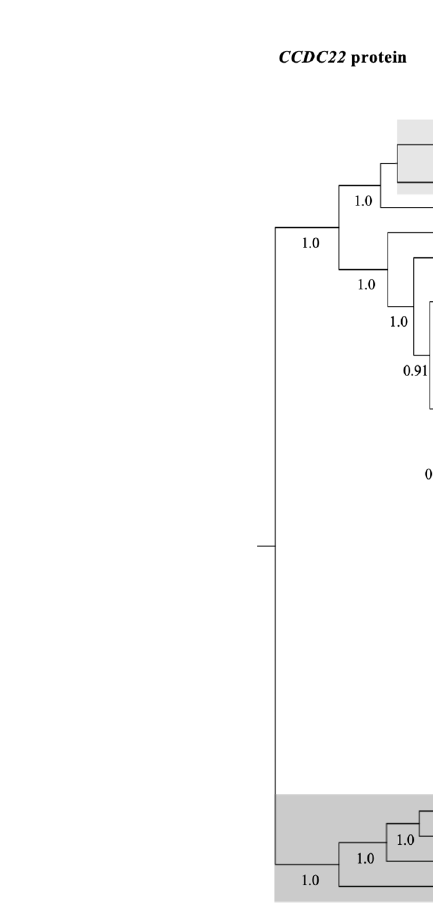
FIGURE 3 Majority rule consensus tree based on Bayesian phylogenetic analyses of aligned CCDC22 protein sequences. Numbers below branches denote Bayesian posterior probabilities above 0.89. CCDC proteins/genes from Arabidopsis and humans are in bold, and shaded boxes highlight animals (metazoans; dark grey box) and bryophytes (bryophyta; light grey